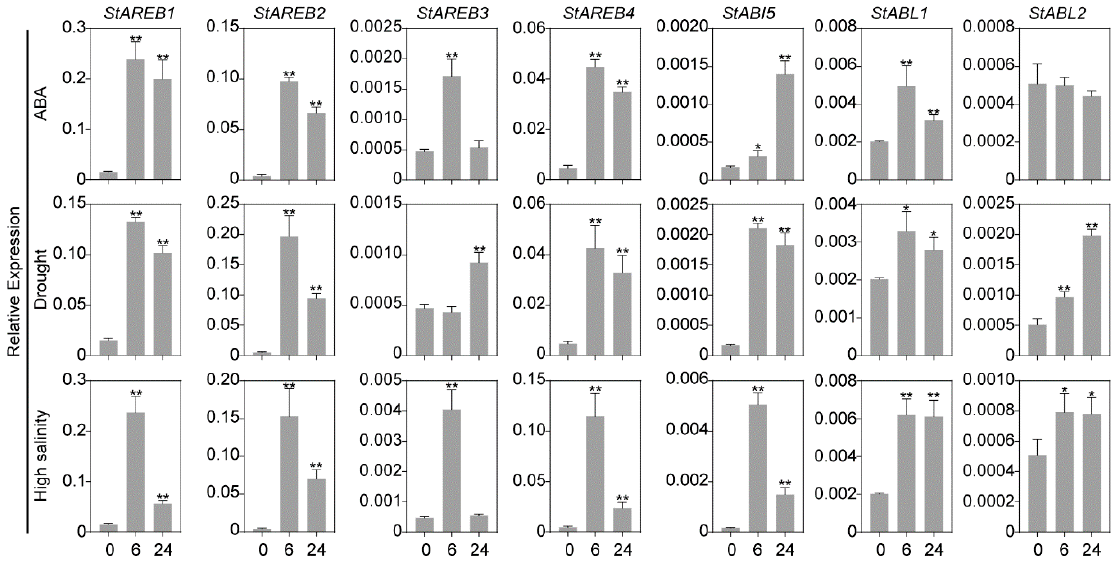
Figure 6. Expression profiles of potato AREB/ABF/ABI5 members under treatments of ABA, dehydration, and high salinity. The relative expression levels are normalized to ef1 α . ABA, dehydration, and high salinity represent the in vitro plants treated with 5 µ M ABA, water deficit, and 125 mM NaCl. The numbers 0, 6, and 24 indicate the time (hour) after treatments. Error bars represent the standard deviation (SD) of three biological replicates. * and ** represents significant differences in p values < 0.5 and < 0.01, respectively.